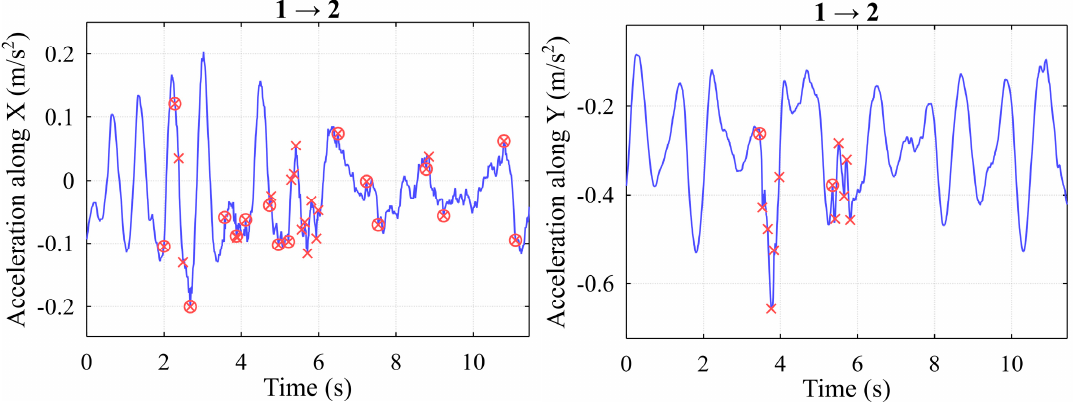
Figure 11. Use case No.3 with the standard IDM parameters (detected impacts: ( left ) 16; ( right ) 2).